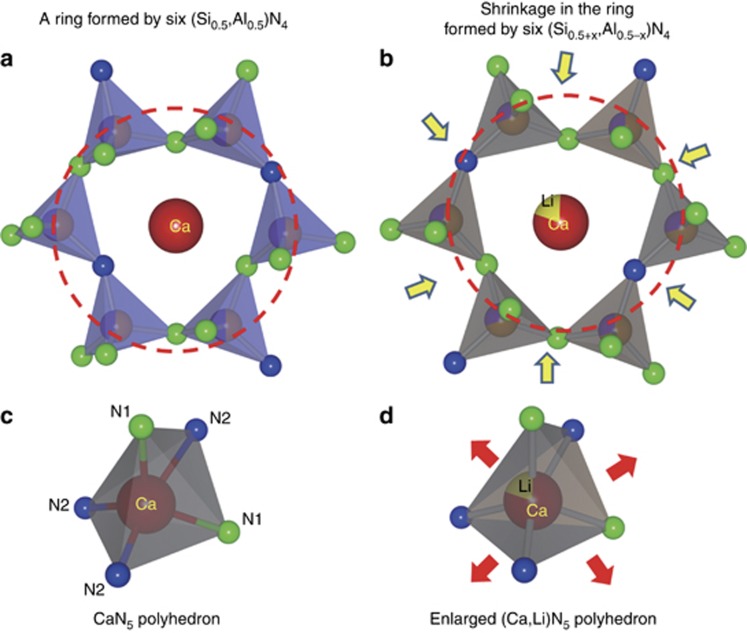
Schematics of the second coordination spheres of (a) CaAlSiN3 and (b) CaAlSiN3–LiSi2N3; the polyhedron of (c) CaN5 and (d) (Ca,Li)N5.